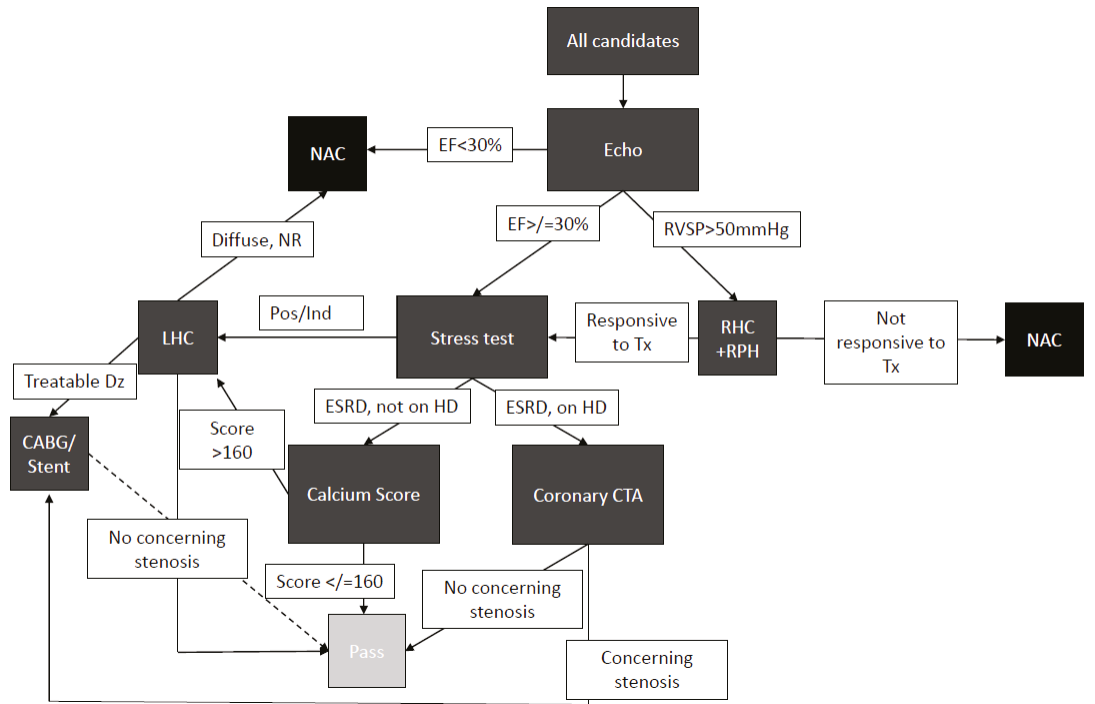
Figure 3. Protocol for cardiac work up in pancreas transplant candidates.